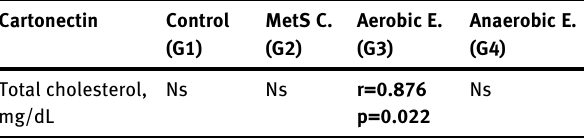
Table  : Signi fi cant correlations with cartonectin in all